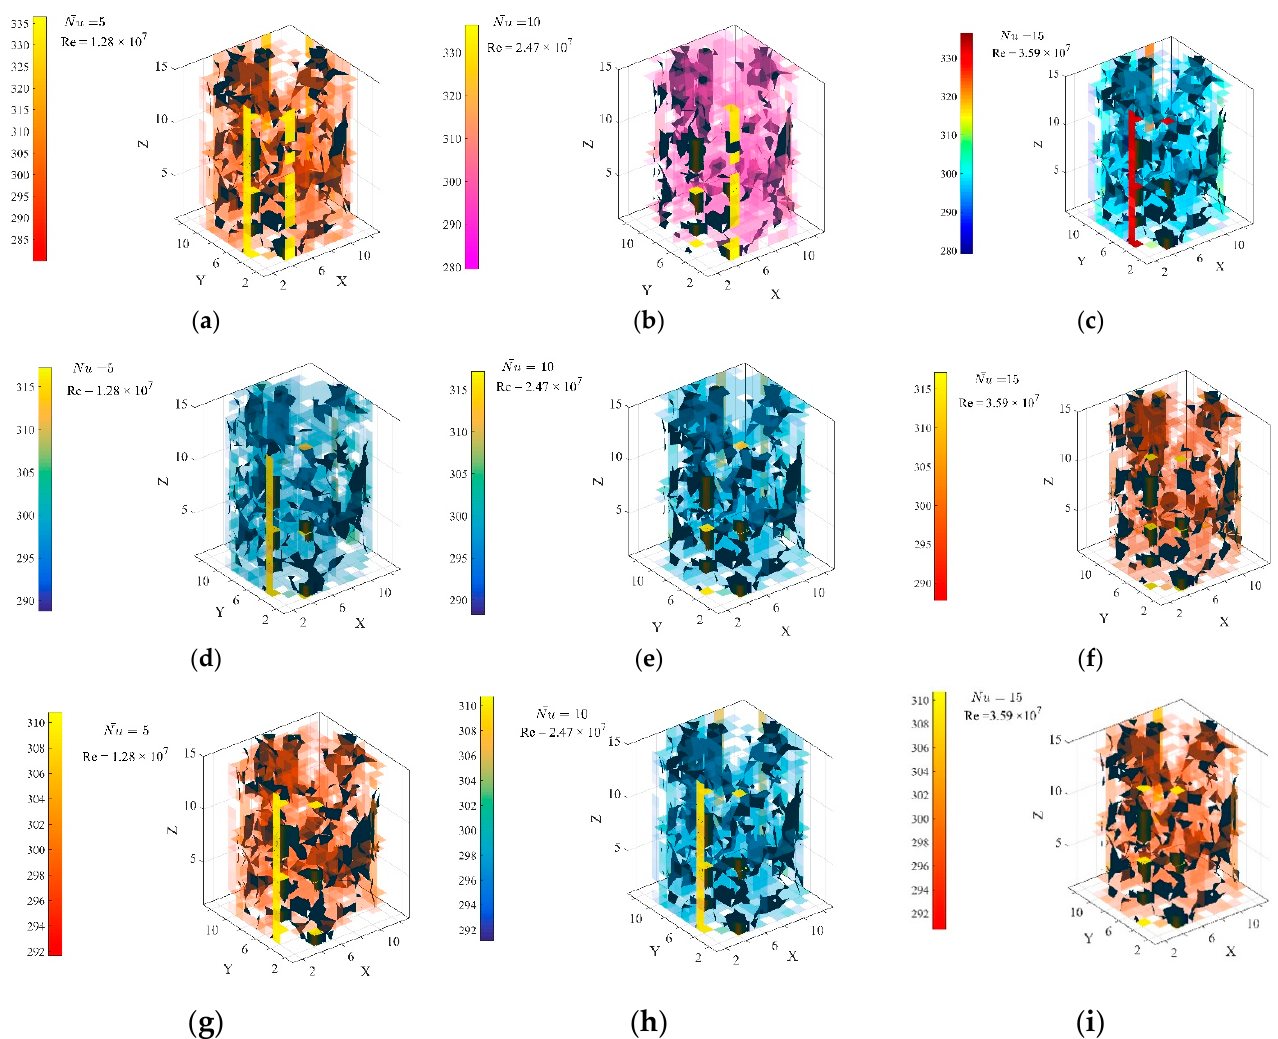
Figure 8. The effect of thermo-fluid properties of inert gas on temperature distribution (isosurfaces) of biofuel during torrefaction (dynamic) at 523 K ( a – c ): 5 min, ( d – f ): 10 min, ( g – i ): 15 min (g = 0, q = 1.430 W·m − 2 ·K − 1 , k = 3.056 W·m − 1 ·K − 1 , Pr = 0.0001988).